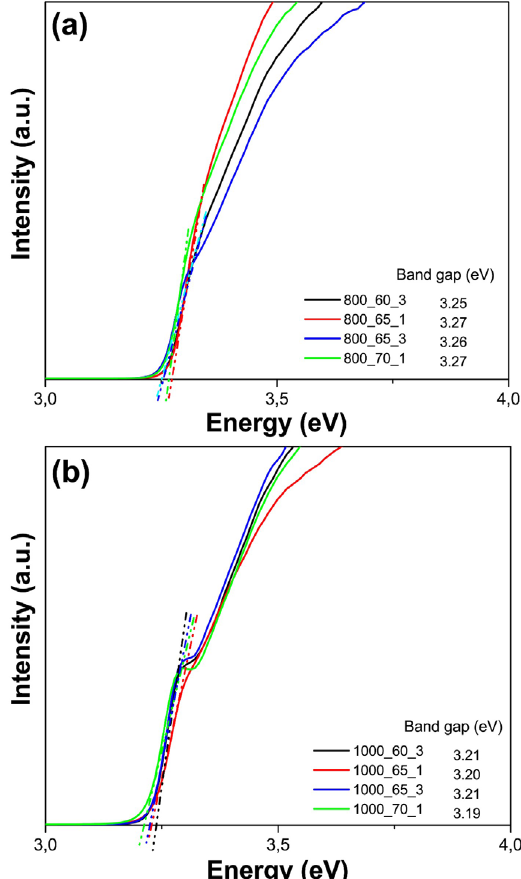
Figure 7. FTIR spectra for heat-treated ZnO ceramics at 800 °C/2 h and 1000 °C/2 h.